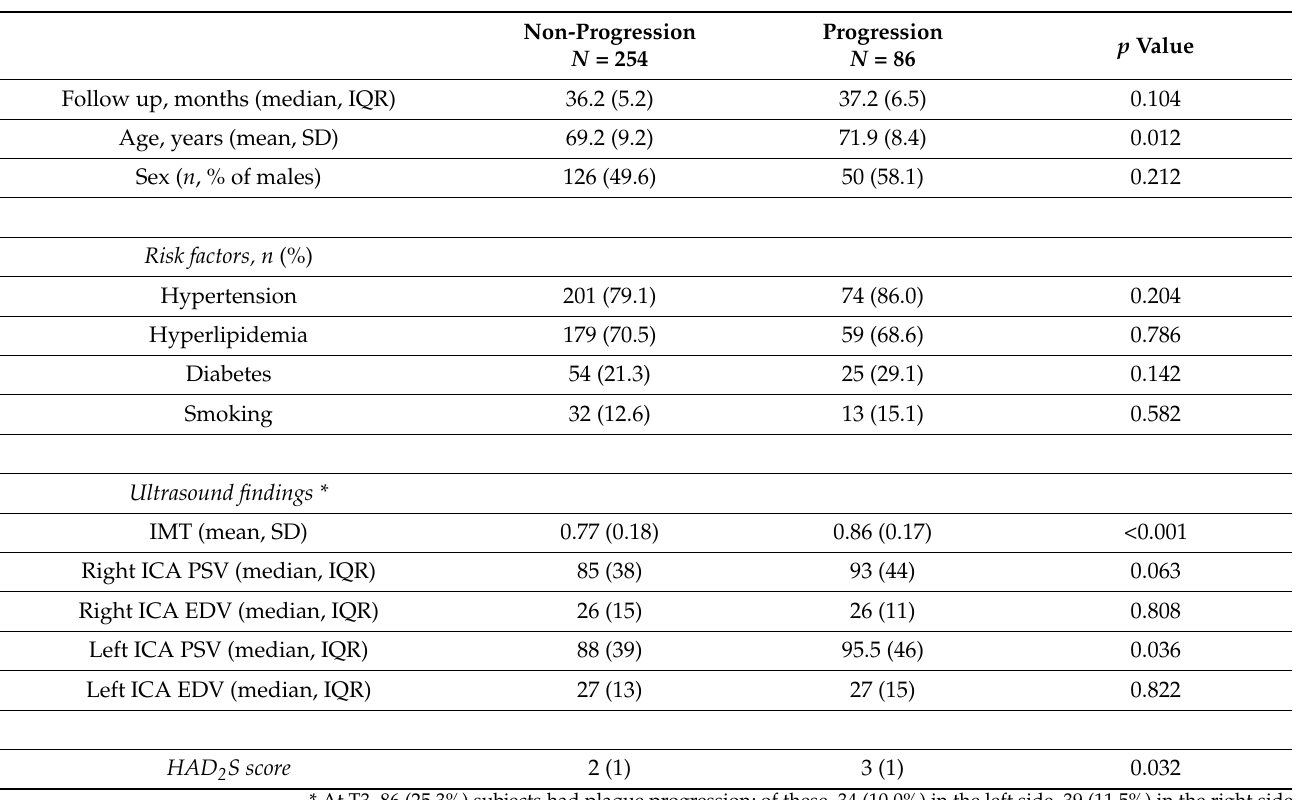
Figure 2. Mean IMT at baseline for each group (non-progression [0] vs. progression [1]). Error bars indicate SD. Table 2. Demographic characteristics, ultrasound findings, percentage of vascular risk factors and the median HAD 2 S score at baseline for each group (non-progression vs. progression).